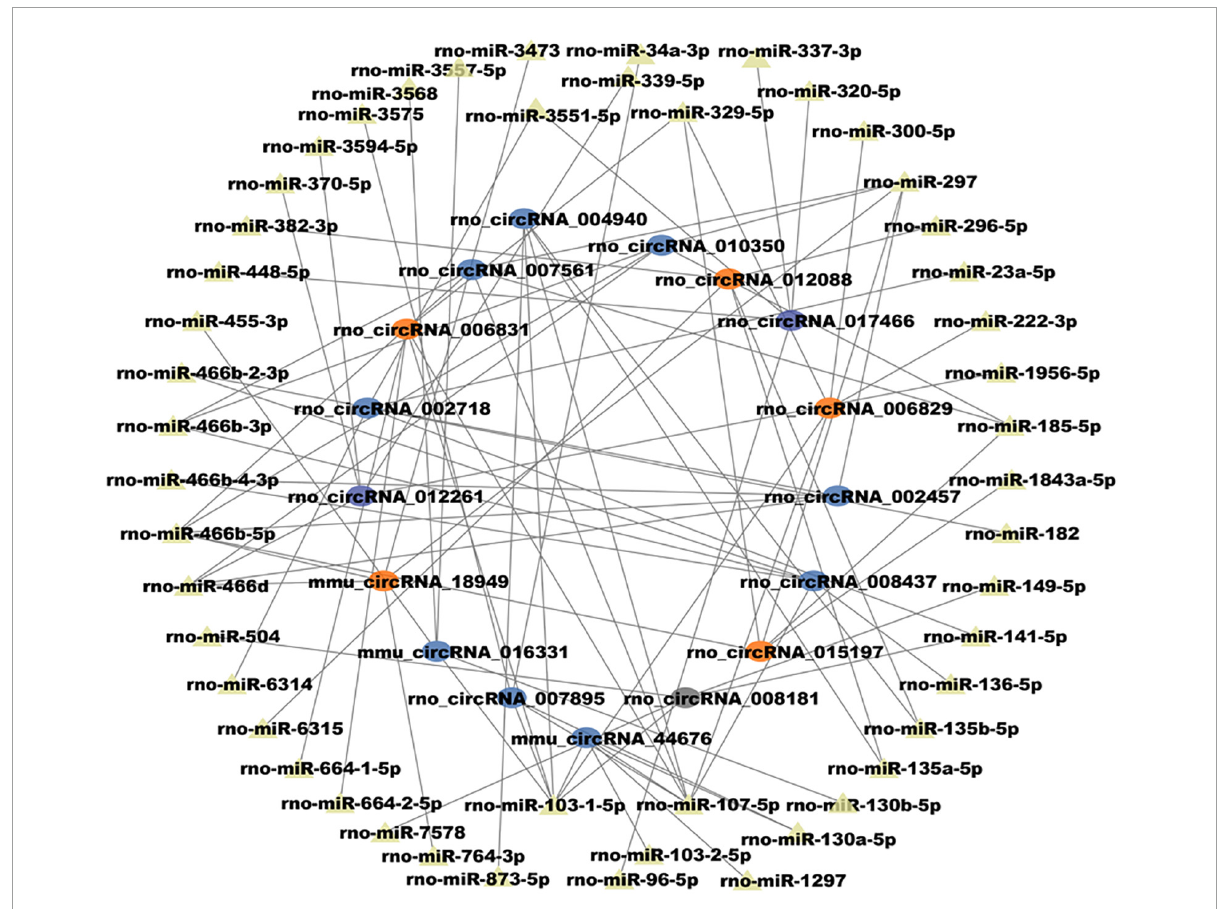
FIGURE4 Construction of circRNA–miRNA networks in morphine tolerance using circRNAs with differences in both m 6 A quantity and m 6 A modification level.